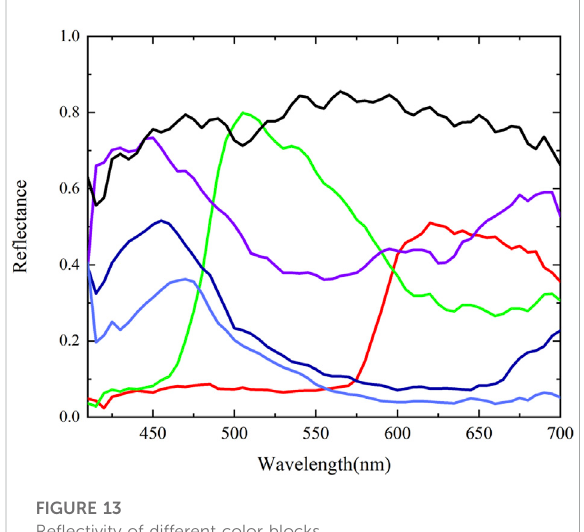
FIGURE 13 Re fl ectivity of different color blocks.